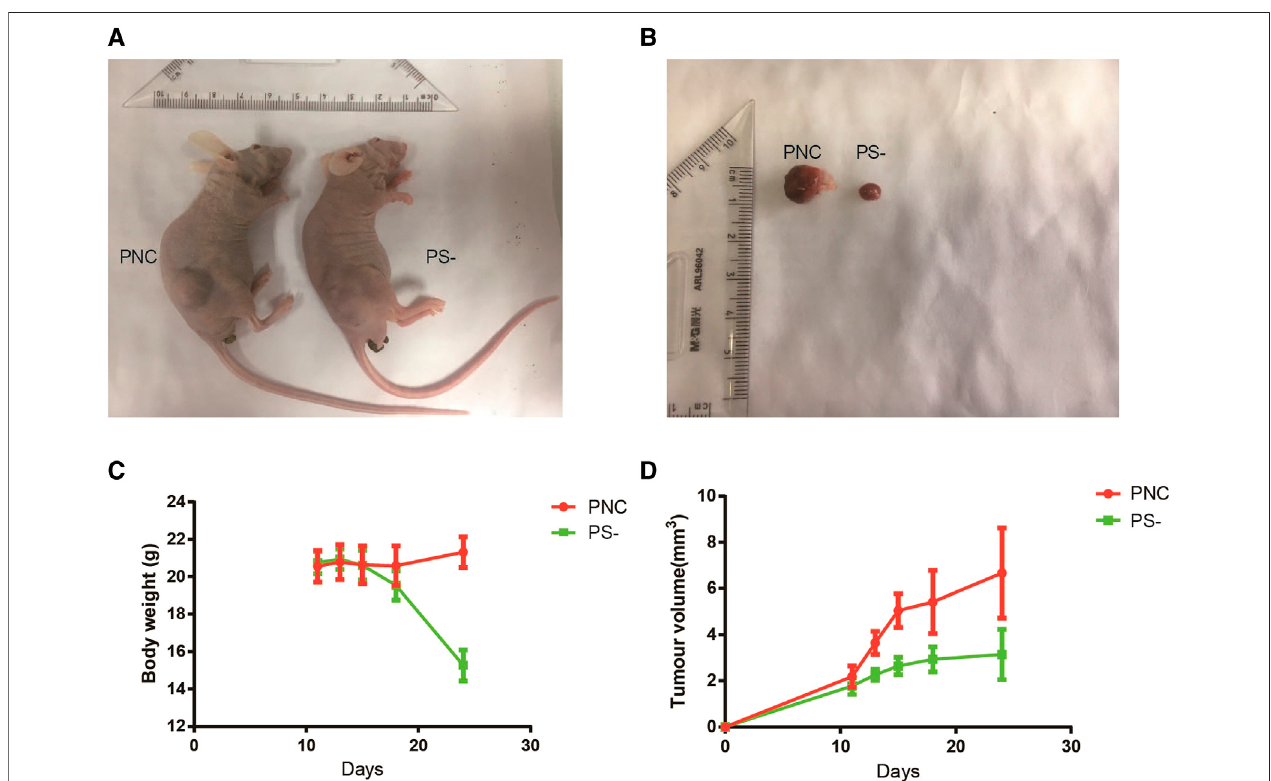
FIGURE 8 | Knockdown of Sestrin2 inhibits the growth of pancreatic cancer in vivo . (A) Picture of nude mice in control group and Sestrin2 knockdown group. (B) Picture of tumor in control group and Sestrin2 knockdown group. (C) Body weight of nude mice in control group and Sestrin2 knockdown group. (D) Tumor volume in control group and Sestrin2 knockdown